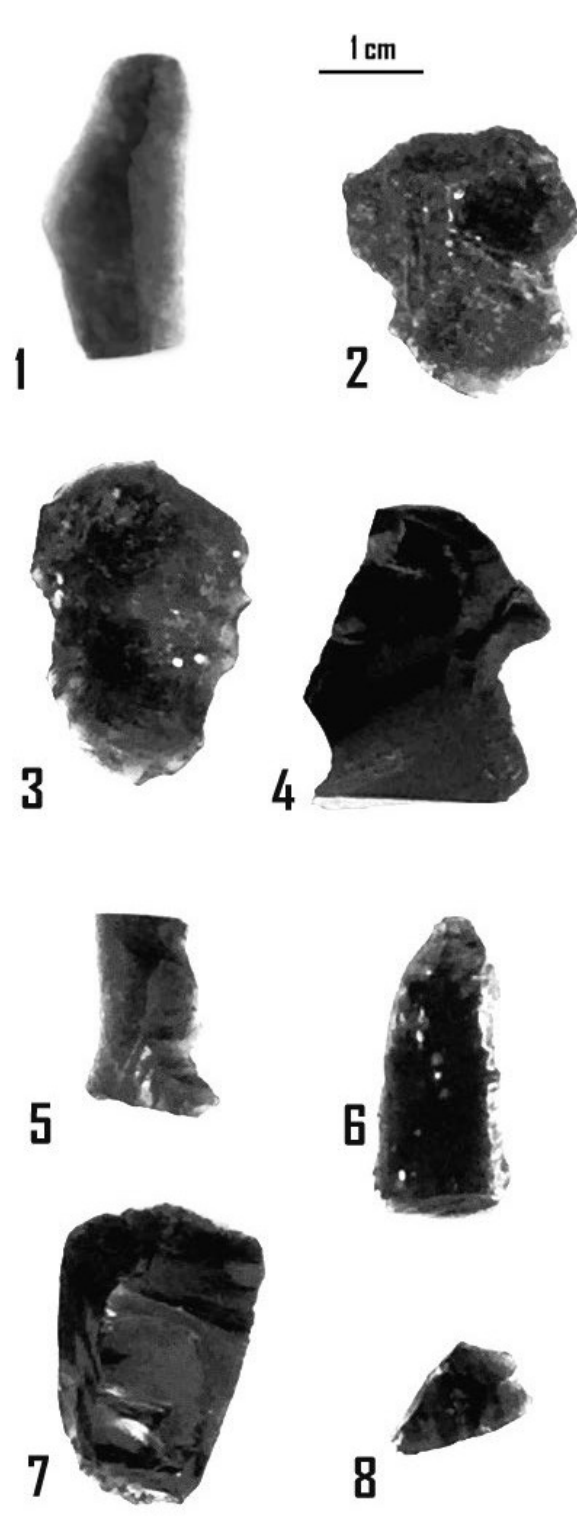
Figure 4: Some obsidian artifacts from Pirozza-Spalmatore (collected on garden surface by Foresta Martin). 1=USF28662, Lipari-Gabellotto, blade; 2=USF28671, Lipari-Gabellotto, flake; 3=USF28666, Lipari-Gabellotto, flake; 4=USF28661, Pantelleria-Lago di Venere, flake; 5=USF28665, Lipari-Gabellotto, blade; 6=USF28663, Lipari-Gabellotto, flake; 7=USF28660, Lipari-Gabellotto, flake; 8=USF28677, Lipari- Gabellotto,